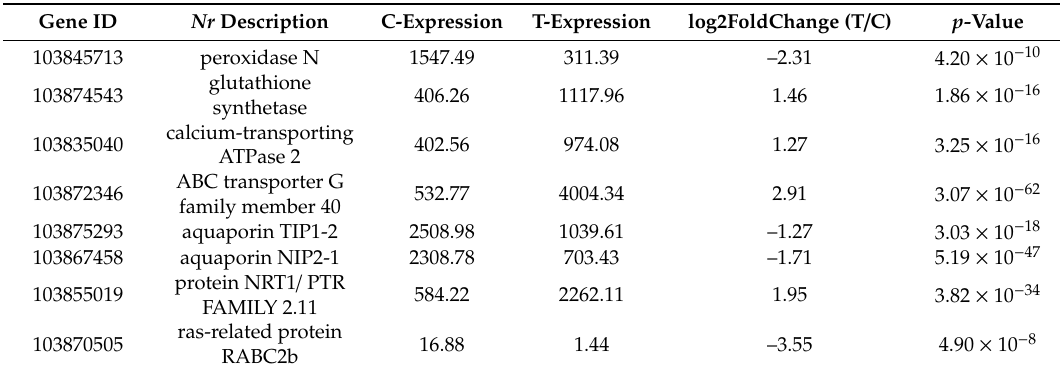
Table 2. Di ff erential expression of eight target genes (relative to reference genes) quantified by qPCR in control and Cd-treated hairy root samples.